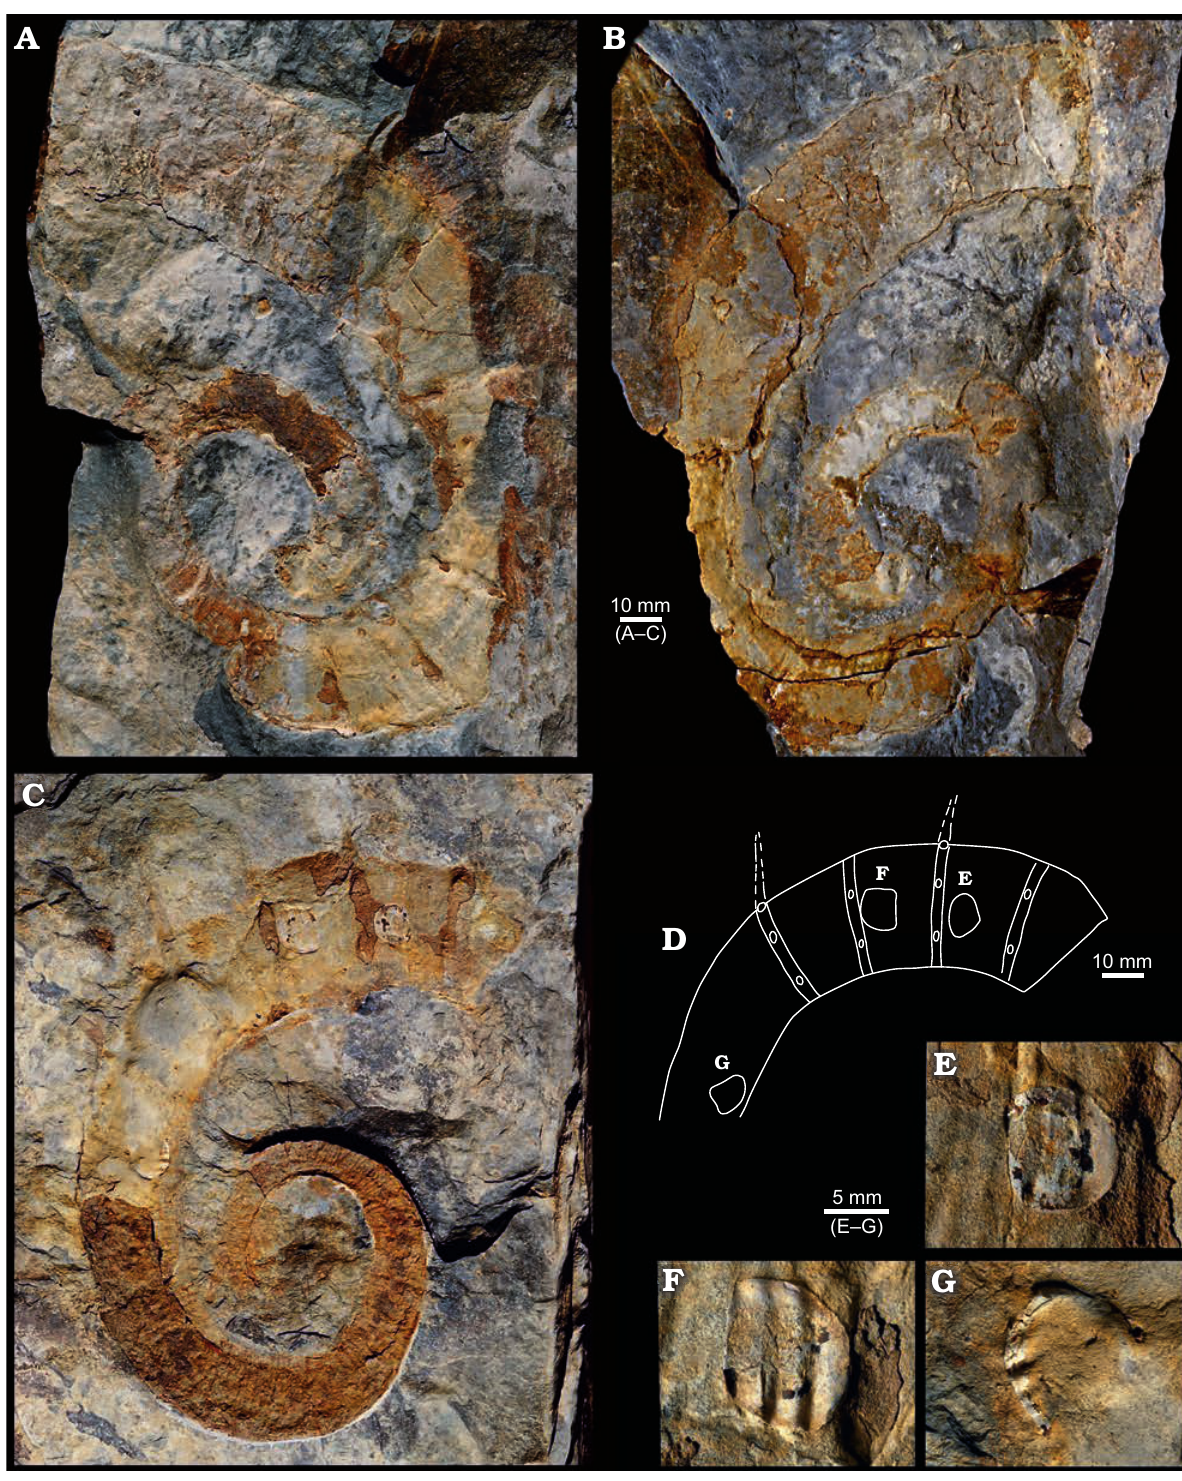
Fig. 4. A – C . The Lower Cretaceous heteromorph ammonite Crioceratites primitivus Reboulet, 1996 from the Kościeliska Marl Formation in the Lejowa Valley, Tatra Mountains, Poland. A . G/1728/MT. B . ZPAL Am. 25/2. C . ZPAL Am. 25/15. D . Distribution of anomiid individuals on a specimen of C. primitivus (ZPAL Am. 25/15). E – G . Close up views of bivalves attached to the body chambers of the ammonite C. primitivus (ZPAL Am. 25/15). All in lateral